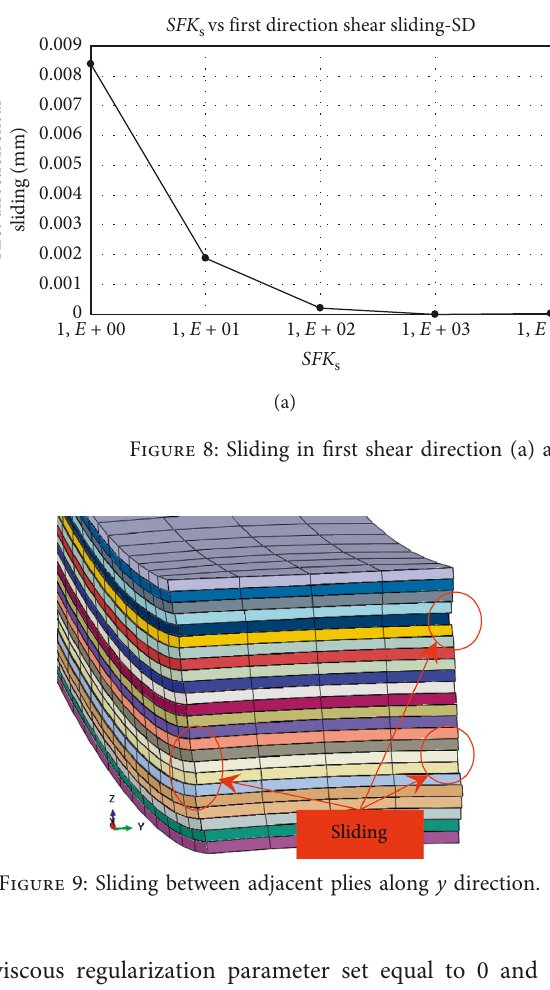
Figure 9: Sliding between adjacent plies along y